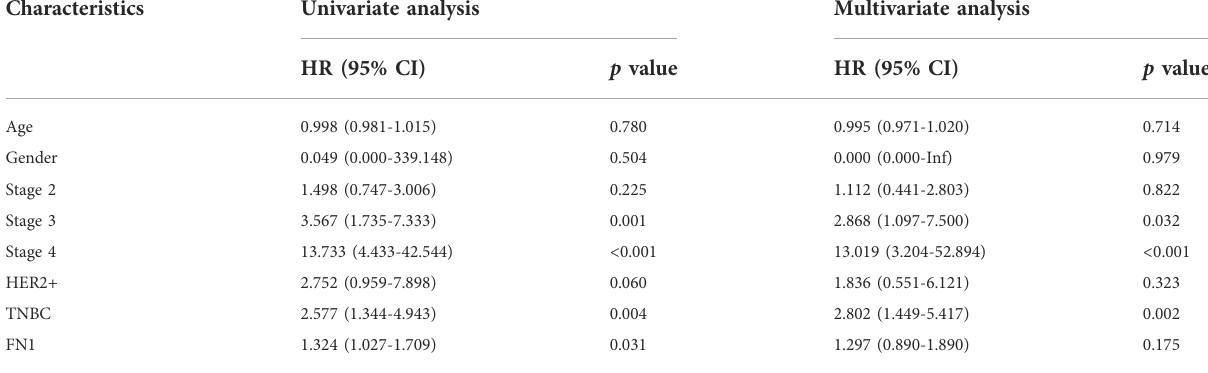
TABLE 4 Relationship between clinicopathological characteristics and breast cancer patient DFS through Cox regression analysis based on TCGA.